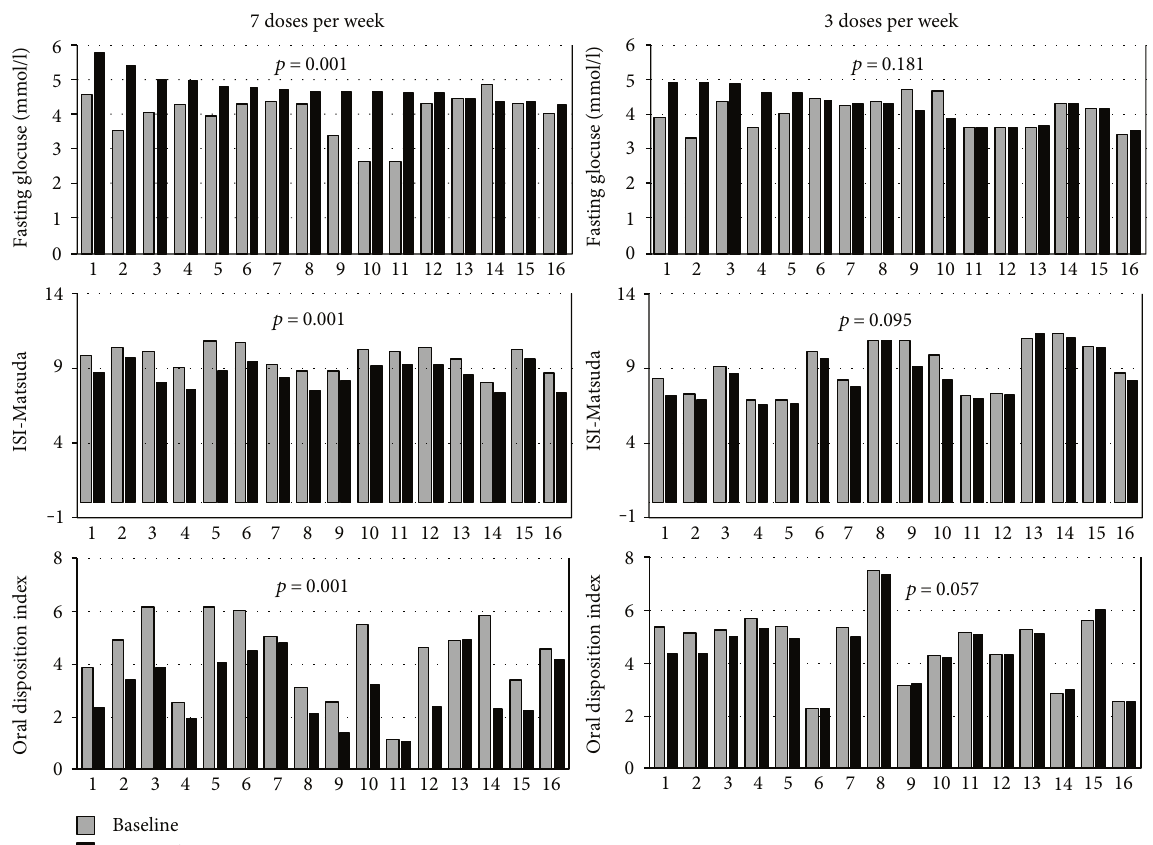
Figure 1: Fasting glucose, ISI-Matsuda, and oral disposition index (DIo) of patients grouped according to the GH treatment regimen (7 or 3 doses per week) at baseline and after 12 months of